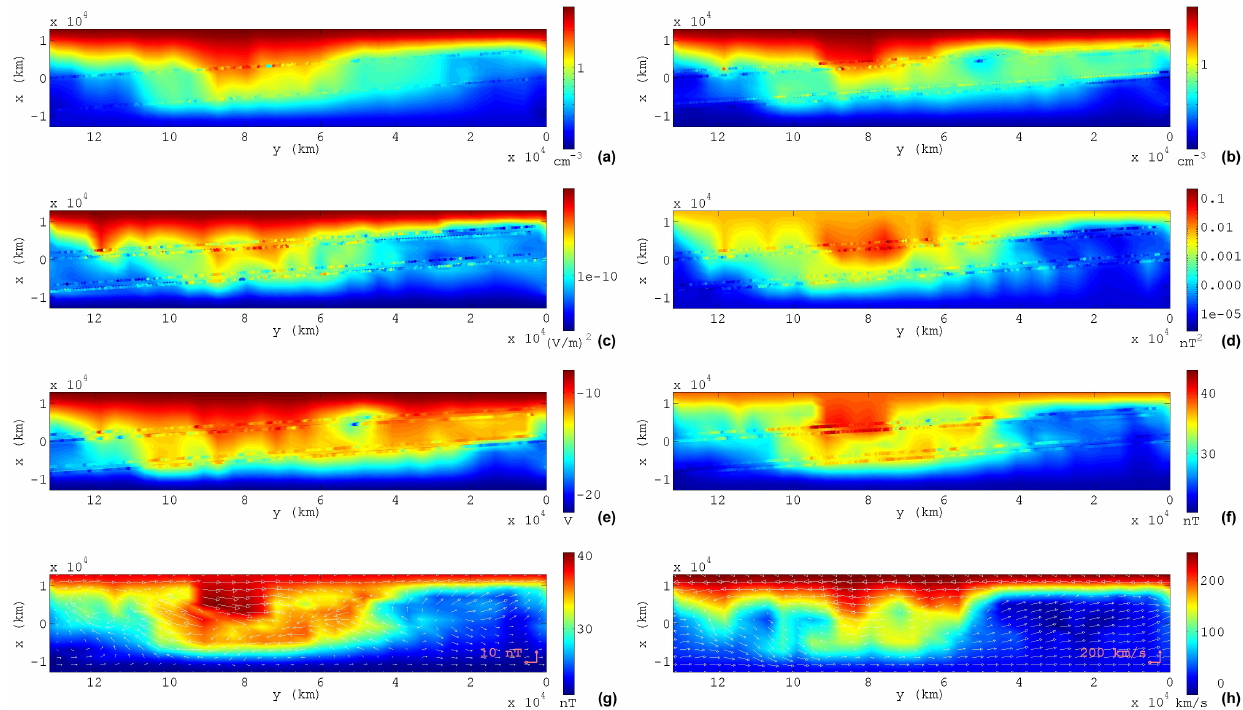
Fig. 6. Reconstruction of the surface wave in the comoving frame. The magnetosheath is at the top, the magnetosphere at the bottom, the Sun to the right, the tail to the left. Each panel shows the reconstruction of a scalar quantity with the measurements superposed on it as colored patches along the spacecraft track. (a) ion density (CIS/HIA). (b) Electron density (PEACE). (c) Electric wave intensity 2–80kHz (WHISPER). (d) Perpendicular magnetic wave intensity 0.3–10Hz (STAFF). (e) Spacecraft potential (EFW). (f) Magnetic field strength (FGM). (g) Magnetic field strength and xy magnetic field vectors (FGM). (h) Ion velocity along z and xy ion velocity vectors (CIS/HIA). Table 1. Magnetospheric and magnetosheath conditions in the comoving frame. Magnetosphere Magnetosheath Ion density